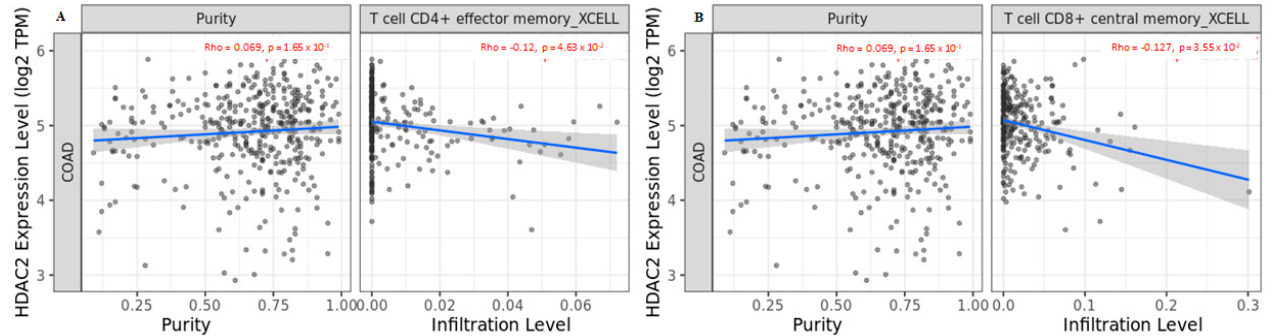
Figure 6. Correlation of HDAC2 expression with ( A ) effector memory CD4 + T cells and ( B ) central